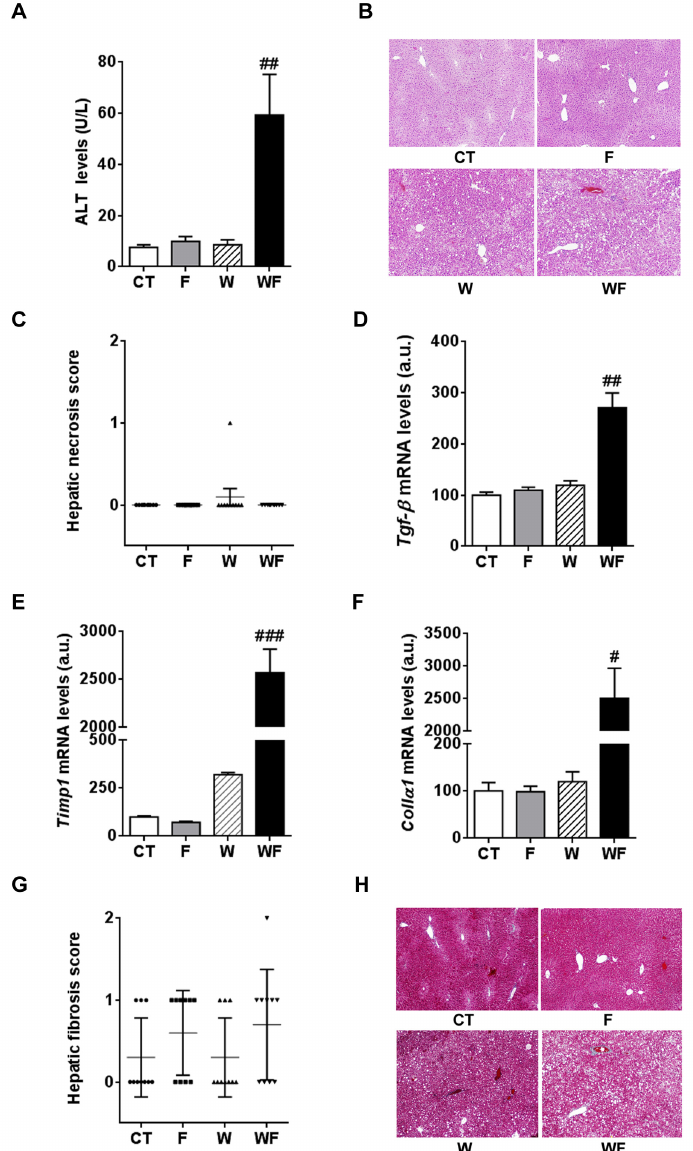
Figure 4. ( A ) Alanine aminotransferase (ALT) activity expressed as mean (U/L) ± SEM of five to six different plasma samples from Control (CT, mice fed standard solid-chow), Fructose (F, mice fed standard solid-chow plus a 15% fructose solution ad libitum), Western (W, mice fed Western solid-chow), and Western + Fructose (WF, mice fed Western solid-chow plus a 15% fructose solution ad libitum); ( B , C ) Histological examination of necrosis by hematoxylin and eosin staining. A representative image of liver sections from each experimental group is shown (magnification 10 × ). The scatter plot shows individual values of necrosis degree (0, absent; 1, <1%). The horizontal line across each group locates the mean, and bars indicate the SEM; ( D – F ) Bar plots showing the relative levels of specific mRNAs of fibrogenesis-related molecules, represented as mean (a.u., arbitrary units) ± SEM of five different liver samples obtained from CT, F, W and WF groups. # p < 0.05, ## p < 0.01, ### p < 0.001 vs. W values; ( G , H ) Histological examination of fibrosis by Masson’s trichrome acid staining. The scatter plot shows individual values of fibrosis score (0, no fibrosis; 1, portal or sinusoidal fibrosis without septa; 2, portal or sinusoidal fibrosis with rare septa). The horizontal line across each group locates the mean, and bars indicate the SEM. A representative image of liver sections from each experimental group is shown (magnification 10×).